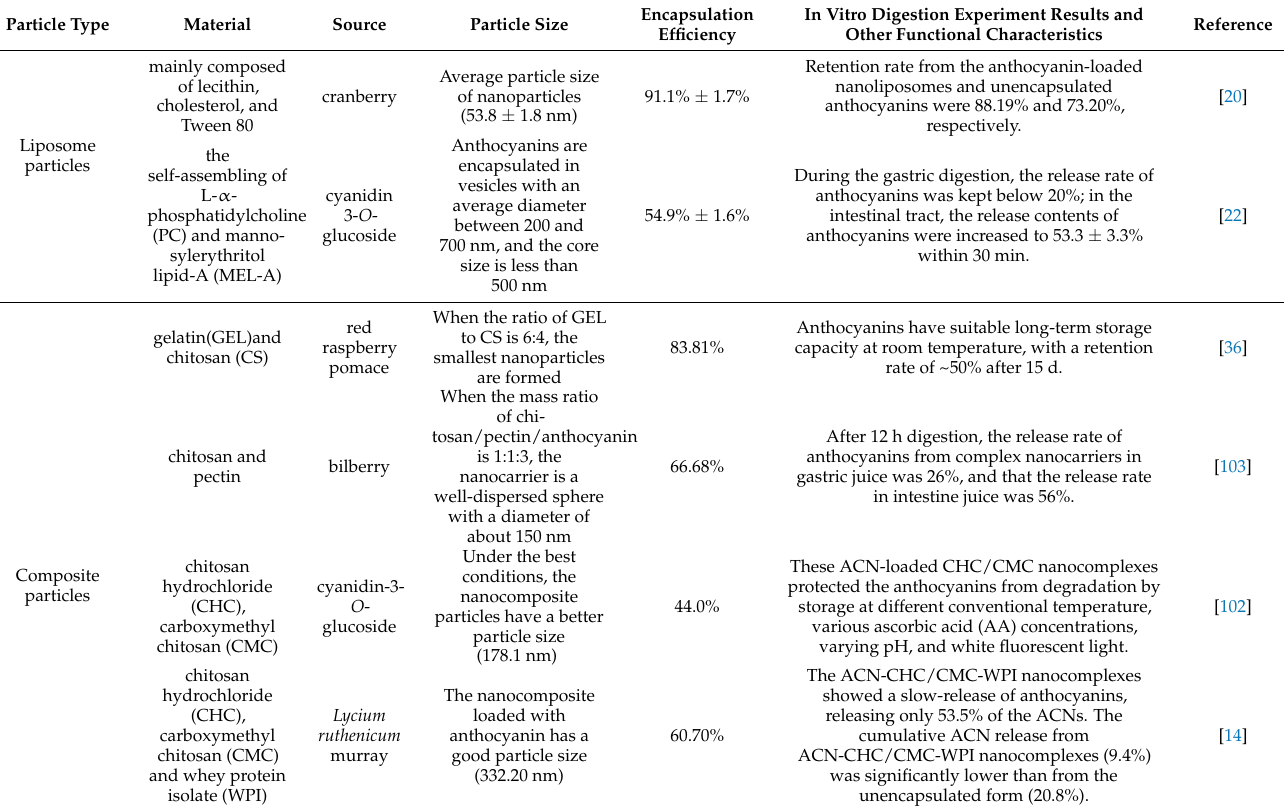
Table 4. Different food-grade particles loaded with anthocyanins and the characteristics of pickering emulsion stabilized by composite